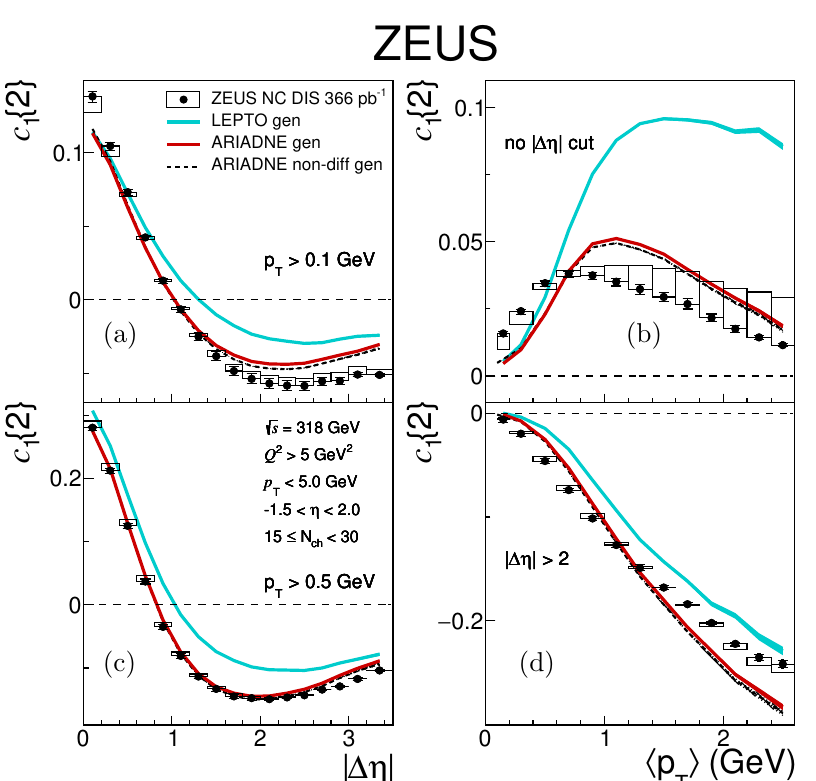
Figure 11 . Correlations c 1 f 2 g as a function of j (cid:1) (cid:17) j and h p T i for 15 (cid:20) N ch < 30. Also shown are generated correlations from Monte Carlo models. Correlations measured in the full kinematic interval are shown in (a) and (b), while (c) and (d) are further constrained by p T > 0 : 5 GeV and j (cid:1) (cid:17) j > 2, respectively. The other details are as in (cid:12)gure